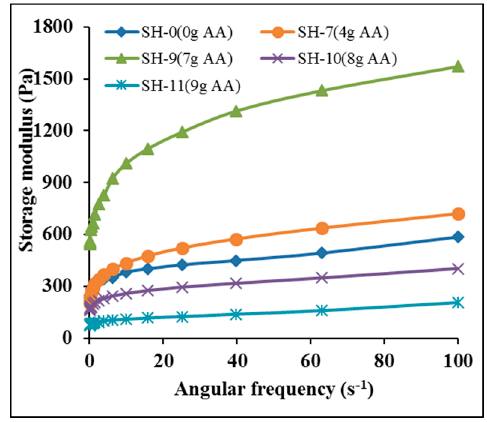
Figure 8. Storage modulus of hydrogels.